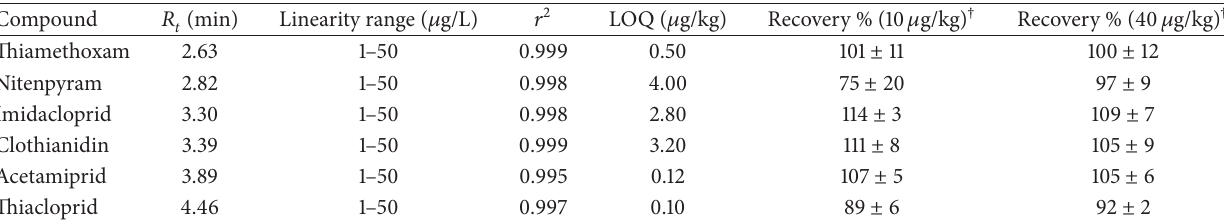
Table 2: Method validation